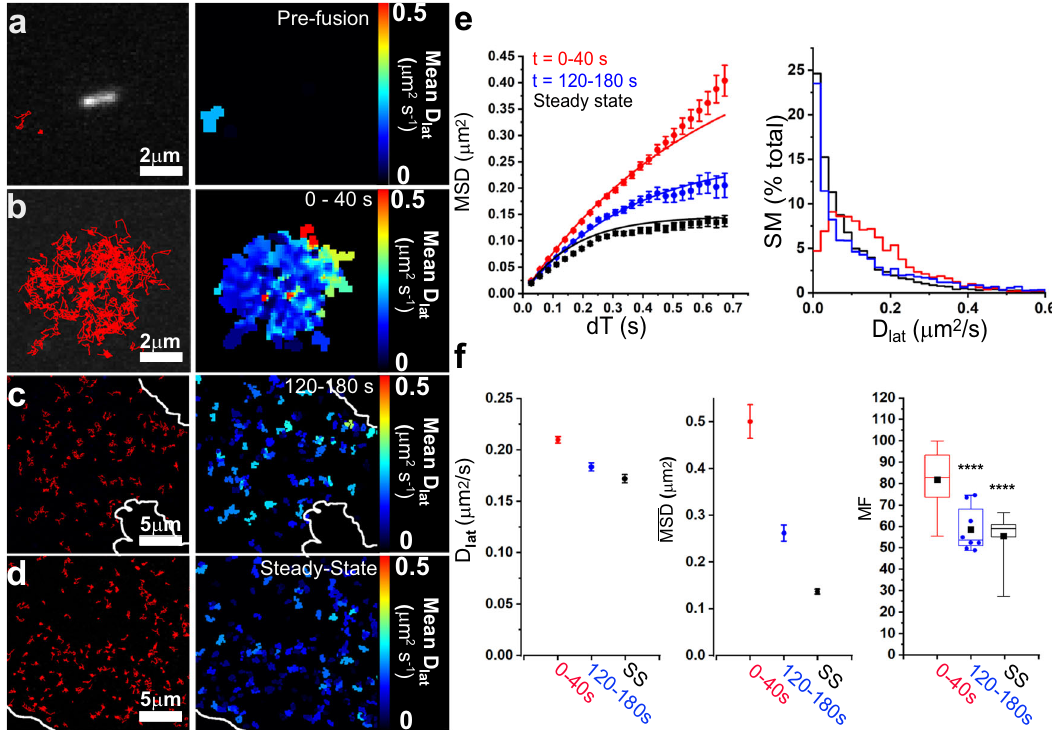
Fig. 1 Mobility of full-length P-selectin-eGFP slows and becomes more restricted with time after exocytosis from WPBs. a – d Single-molecule trajectories are shown for 40 s video records, before, during, and after exocytosis (left panels, red traces. The start time, t = 0, is de fi ned as the moment that fusion occurs. a Molecules present at steady-state, recorded for 40 s prior to stimulation ( n = 2 SMs). Note the Weibel – Palade Body present in the center; b Data recorded for 40 s immediately after exocytosis ( t = 0 – 40 s) triggered by 100 µ M histamine;. Here, the x-y centroids of fi ve separate exocytosis events were set to the center of the image and videos were concatenated for analysis ( n = 129 SMs, fi ve fusion events); c t = 120 – 180 s after exocytosis and d under steady-state ( “ SS ” ) conditions. In the corresponding panels (right) the same tracks are pseudo-colored to report their mean lateral diffusion coef fi cient ( D lat ) over the track duration. White lines in c , d show cell boundaries. e MSD vs dT plots (left) (dots show the mean MSD value at each given dT and vertical bars delimit± s.e.m.) and distributions of D lat (right); shown for different times after exocytosis: Red, t = 0 – 40 s (3522 SMs, n = 66 exocytosis events from 20 cells); Blue, t = 120 – 180 s post-exocytosis (2700 SMs, n = 12 cells) and Black: steady-state (3012 SMs, n = 14 cells). f D lat values and limiting MSD obtained by least-squares fi tting the data in e (left) to Eq. (1) (vertical bars delimit ±95% con fi dence intervals of the least- squares fi ts); mobile fractions, MF, (de fi ned as molecules with D lat > 0.05 µ m 2 s − 1 ): Shortly after exocytosis ( t = 0 – 40 s) gave 82.0 ± 1.8%, s.e.m. ( n = 20 cells, 66 fusion events, four experiments); post-exocytosis ( t = 120 – 180 s) gave 57.4 ± 3.7% ( n = 8 cells; three experiments); one-way ANOVA vs “ 0 – 40 s ” , **** P = 0.0004; steady-state ( “ SS ” ) gave 54.3 ± 2.8% ( n = 14 cells, four experiments); one-way ANOVA vs t = 0 – 40 s, **** P < 0.0001). Box and Whiskers: where: Boxes show 25 – 75% data range, horizontal line is median, solid symbol is mean, Whiskers delimit 5 – 95% of data, and all data points shown if n < exocytosis (Fig. 2a – c). Both Δ CTLD and Δ CTLD-EGF mutants showed an identical increase in mobility at exocytosis (Fig. 2b – d), indicating the N-terminal CTLD hinders P-selectin movement even at the earliest time point. The TMD mutant, which was present constitutively at the plasma membrane, exhibited rapid and unconstrained diffusion ( D lat = 0.4 μ m 2 s − 1 , see Fig. 3a) similar to Δ CTLD and Δ CTLD-EGF mutants at the time of exocytosis (Fig. 2b). The Δ CT, Δ 4CR, and Δ 8CR mutants showed little difference compared to the parent molecule at the time of secretion (summarized in Fig. 2b-d). At later times, the MSD vs dT relationships for Δ CTLD and Δ CT showed much less- pronounced downward-curvature than the full-length molecule (Fig. 3a, b). Together, these fi ndings indicate that the time- dependent changes in mobility are unlikely to be due to lipid mixing between WPB and plasma membranes, but instead are controlled by the independent and additive effects of the pro- truding CTLD and CT domains.